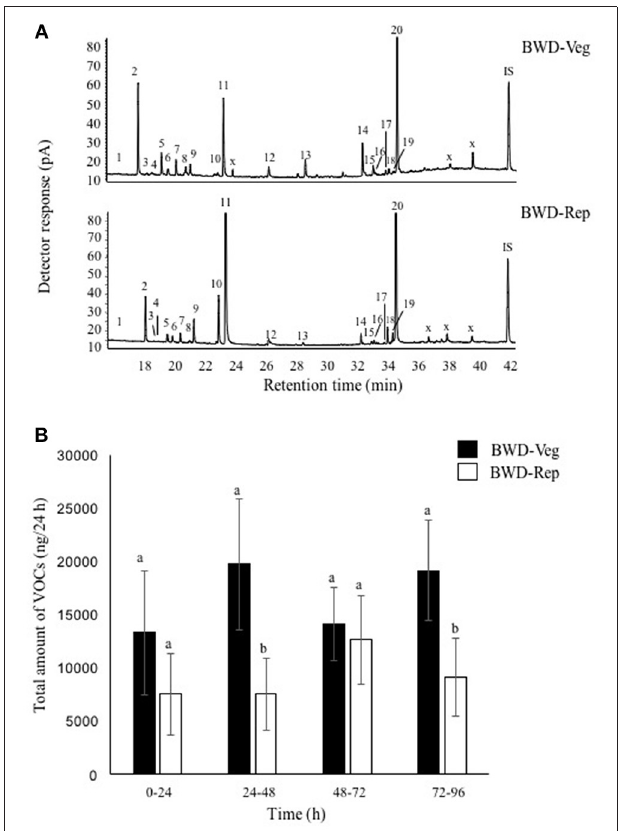
FIGURE 1 | Qualitative and quantitative profiles of herbivore-induced volatiles from vegetative and reproductive stages of cotton plants. (A) Representative chromatograms of air-entrainment of boll weevil-damaged cotton at 72–96h. Numbers represent compounds: (1) ( E )-2-methylbutanal oxime, (2) α -pinene, (3) benzaldehyde, (4) camphene, (5) β -pinene, (6) myrcene, (7) ( Z )-3-hexenyl acetate, (8) limonene, (9) ( E )-ocimene, (10) ( R )-linalool, (11) DMNT, (12) methyl salicylate, (13) indole, (14) ( E )-(1 R ,9 S )-caryophyllene, (15) geranylacetone, (16) α -humulene, (17) δ -guaiene, (18) δ -cadinene, (19) nerolidol, and (20) TMTT. (B) Amounts (mean ± SEM) of total volatiles from boll weevil-damaged cotton plants. Means with the same letter within a given time that the plants were sampled (0–24, 24–48, 48–72, or 72–96h after treatment was started) are not different ( P > 0.05) by General Linear Model (GLM) and ANODEV and mean comparisons by contrast analyses. BWD-Veg, boll weevil-damaged vegetative cotton. BWD-Rep, boll weevil-damaged reproductive cotton.